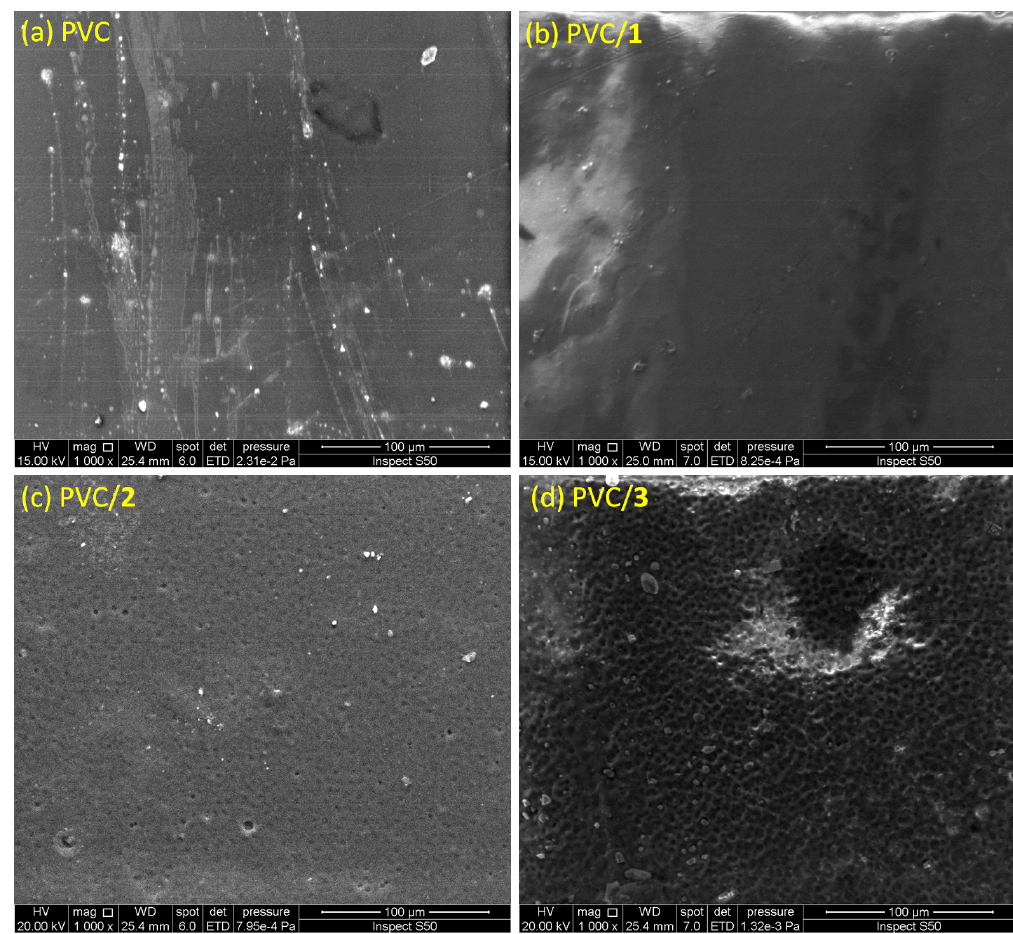
Figure 12. Scanning electron microscopy (SEM) images of ( a ) the blank PVC film and the PVC films containing ( b ) complex 1 , ( c ) complex 2 , and ( d ) complex 3 after irradiation for 300 h.